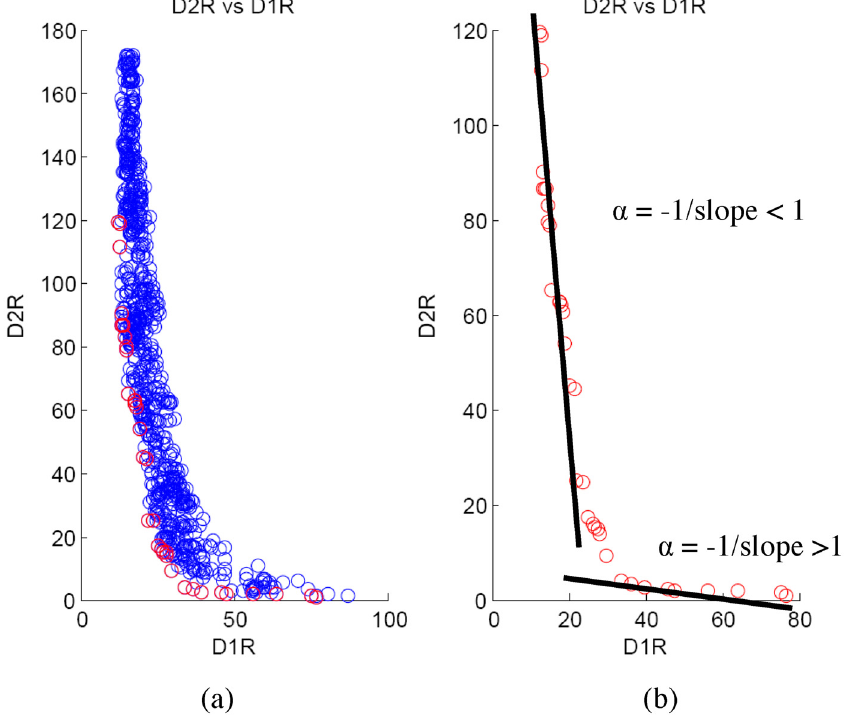
Fig 2. D 2 vs D 1 for right node. (a) shows an example Pareto frontier (red circles) for the right child node for the first split of a specific tree (the D 1 and D 2 values are denoted by D 1 R and D 2 R respectively). (b) shows that the Pareto frontier can be approximated by two straight lines: one with slope greater than 1 and another with slope less than